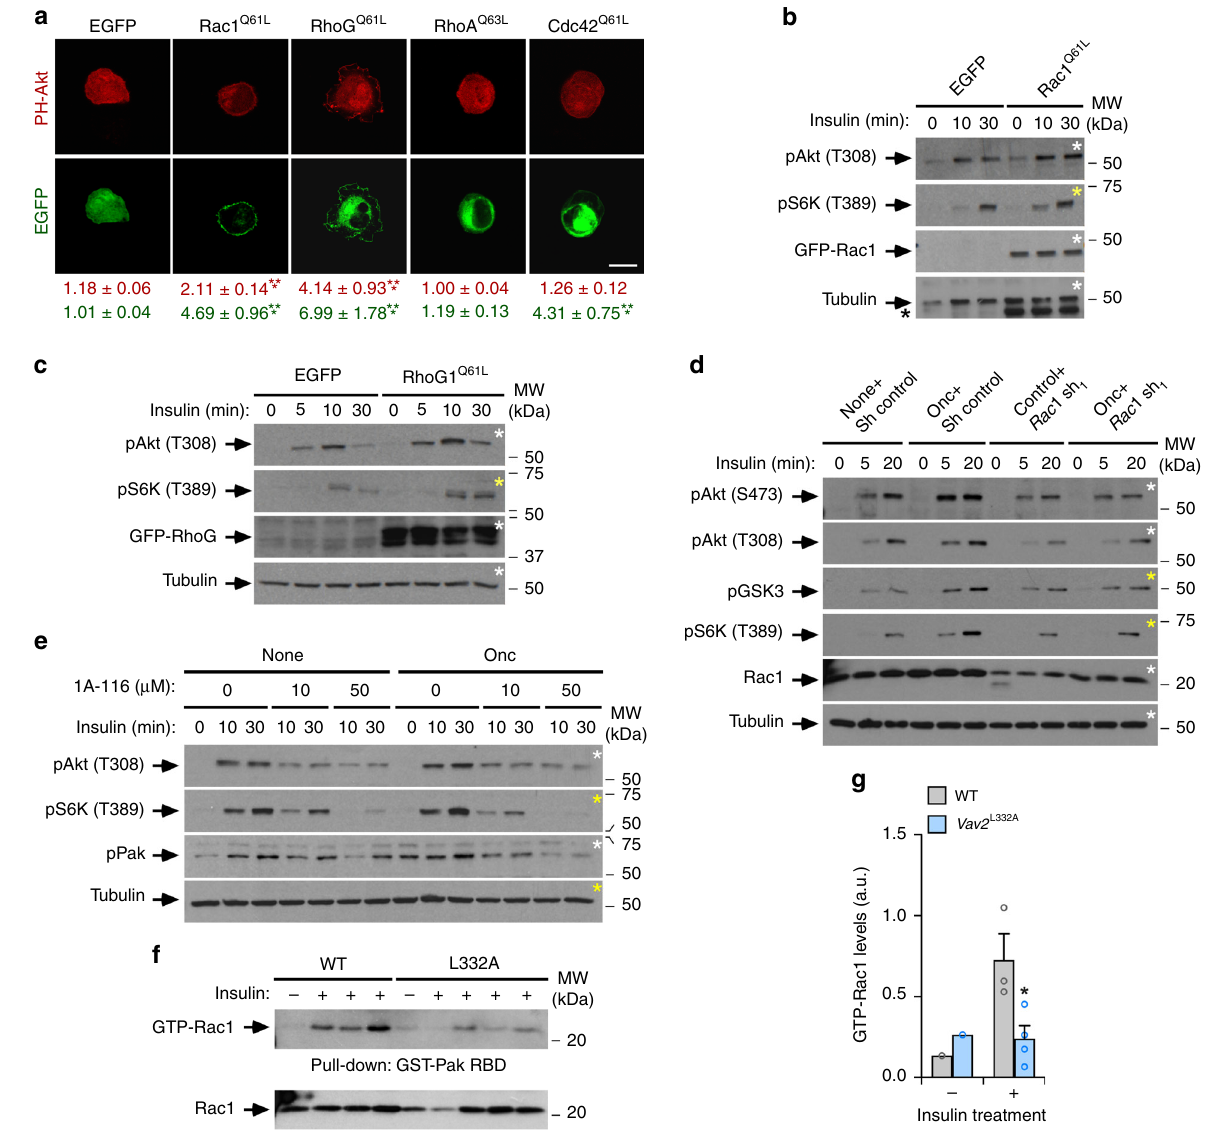
Fig. 5 Vav2 regulates the PI3K α -Akt pathway in a Rac-dependent manner. a Representative image showing the subcellular localization of mCherry-Akt PH in starved, nonstimulated C2C12 cells transiently transfected with the indicated proteins (top). The quanti fi cation of the plasma membrane (PM) to cytoplasm (Cyt) ratio of the mCherry-Akt PH bioreporter (red) and the indicated EGFP-GTPase (green) is shown at the bottom. Values represent the mean ± SEM. ***, P = 0.000006 (Rac1 Q61L , EGFP), P = 0.0008 (Rac1 Q61L , PH-Akt), P = 0.00007 (RhoG Q61L , EGFP), P = 0.000005 (RhoG Q61L , PH-Akt), and P = 0.000006 (Cdc42 Q61L , EGFP) relative to the cells transfected with an empty vector using a Kruskal – Wallis test and two-sided Dunn ’ s multiple comparison tests ( n = 3 independent experiments). Scale bar, 10 μ m. b , c Representative immunoblots of the phosphorylation levels of indicated proteins and phosphosites (left) in cells transiently expressing the speci fi ed EGFPs (top) upon insulin stimulation (top). The asterisks show the remaining EGFP- Rac1 signal that was carried over from the previous immunoblot analysis of the same fi lter. d Phosphorylation levels of the speci fi ed phosphosites and proteins (left) in the indicated insulin-stimulated C2C12 cells. Sh shRNA. e Representative immunoblot showing the levels of indicated phosphorylated sites and total proteins (left) in the speci fi ed cell lines that were stimulated with insulin for the indicated periods and either in the absence or presence of the indicated amounts of the 1A-116 inhibitor (top). n = 3 independent experiments. f GTP-bound levels of Rac1 in the skeletal muscle from 3-month-old mice of indicated genotypes (top) that were infused with insulin as indicated (top panel). As a control, aliquots of the same total cell lysates were analyzed in parallel (bottom panel). RBD Rac-binding domain. g Quanti fi cation of the fraction of GTP-bound Rac1 found in the experiments shown in f . Data are shown as mean ± SEM. *, P = 0.0338 relative to insulin-stimulated WT mice using two-tailed Student ’ s t tests. n = 3 (WT) and 4 ( Vav2 L332A/L332A ) insulin- stimulated animals. Source data for this fi gure are provided as a Source data fi